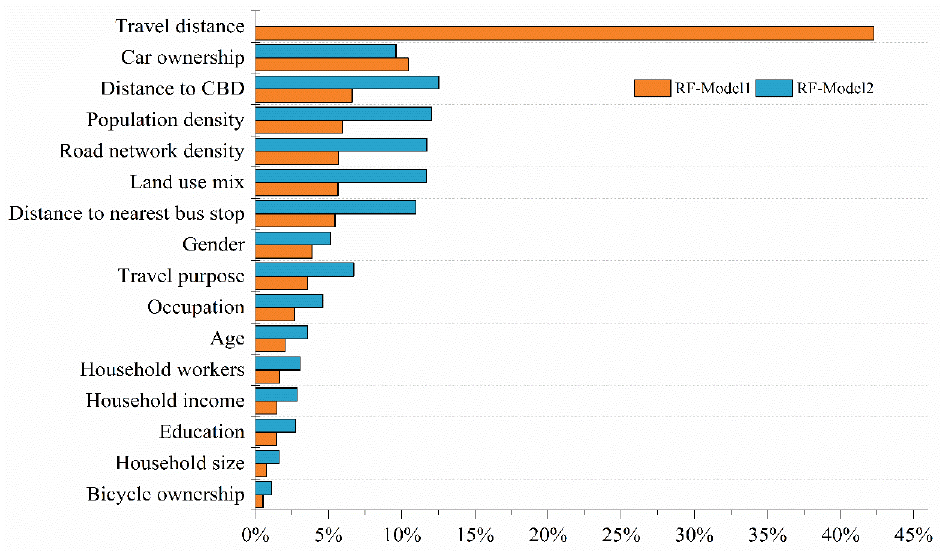
Figure 5. Comparison of relative importance of feature variables. Table 4. Relative importance of variables among the three travel modes in RF-Model1.